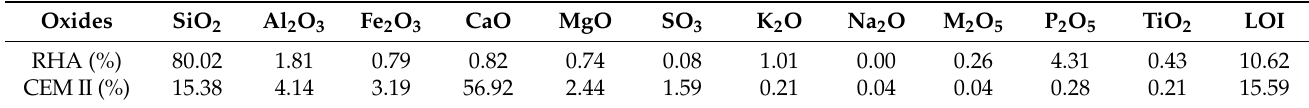
Table 4. Chemical composition of CEM II and RHA. (Nduka et al., 2021).